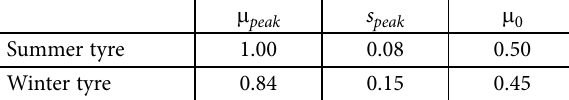
Figure 13. Adhesion characteristics m ( s ) for summer and winter